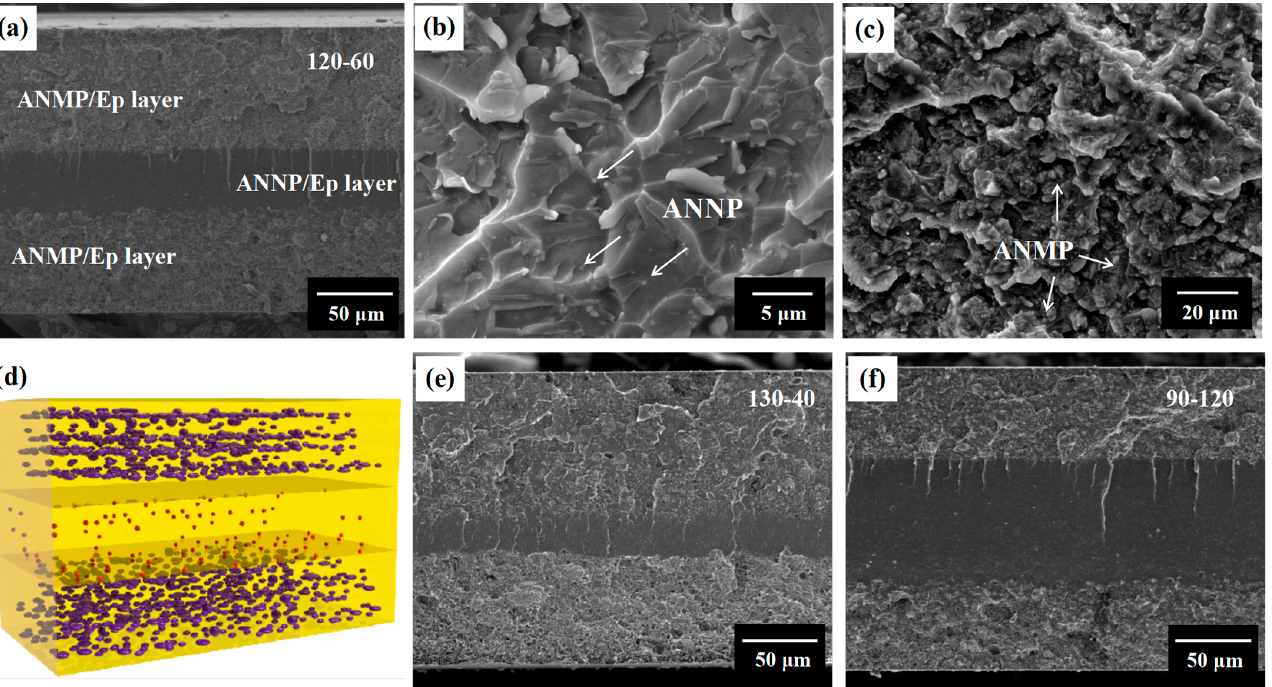
Figure 2. Cross-section SEM images of ( a ) 120-60, ( e ) 130-40 and ( f ) 90-120; Corresponding enlarged SEM images of ( b ) the inner layer with 1.0 vol.% ANNP in 120-60 and ( c ) the outer layer with 35.6 vol.% ANMP in 120-60; ( d ) schematic of the sandwiched composite.